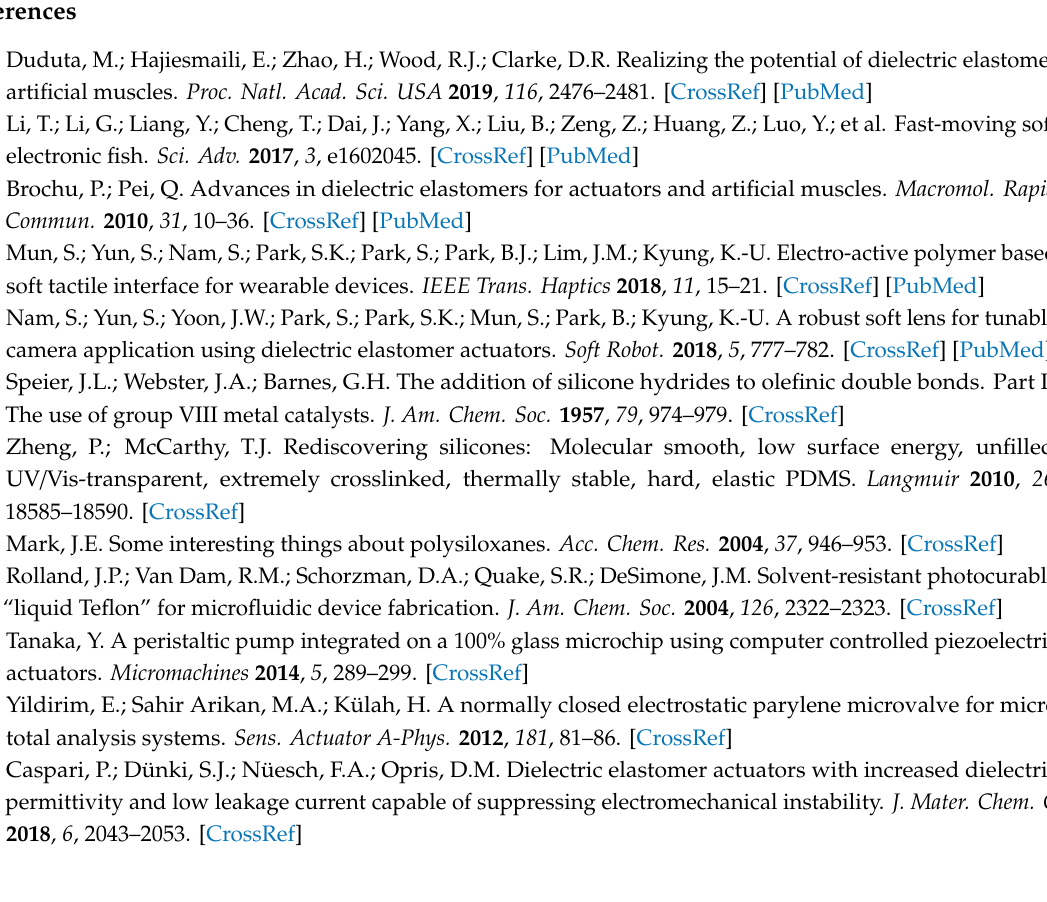
Figure S1: IR (a), 1 H NMR (b), 12 C NMR (c), and GPC spectra (d) of VPDMS; Figure S2: IR (a), 1 H NMR (b), 12 C NMR (c), and GPC spectra (d) of HPDMS10; Figure S3: IR (a), 1 H NMR (b), 12 C NMR (c), and GPC spectra (d) of HPDMS20; Figure S4: A photograph of the synthesized PDMS copolymers; Figure S5: IR spectrum of the dope layer prepared from HPDMS10 and TEGDE before and after curing at 80 ◦ C for 2 h; Figure S6: Isothermal TGA curves of TEGDE at di ff erent temperatures; Figure S7: IR spectra of the dope layers prepared from VH10 (a), VH10T (b), VH20T (c) before and after curing at 80 ◦ C for 2